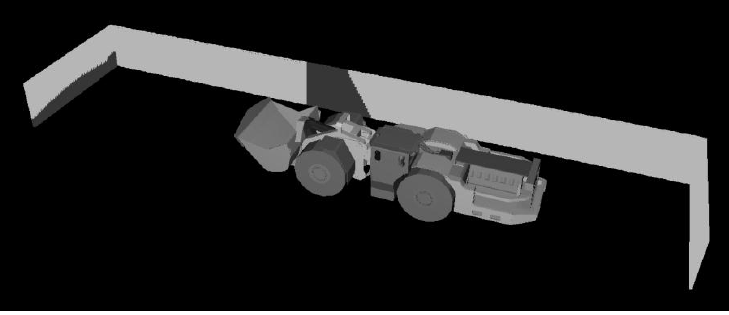
Figure 4. Straight LHD in a straight drift with view from best of four-camera system (light area = LOS, dark area = no LOS).